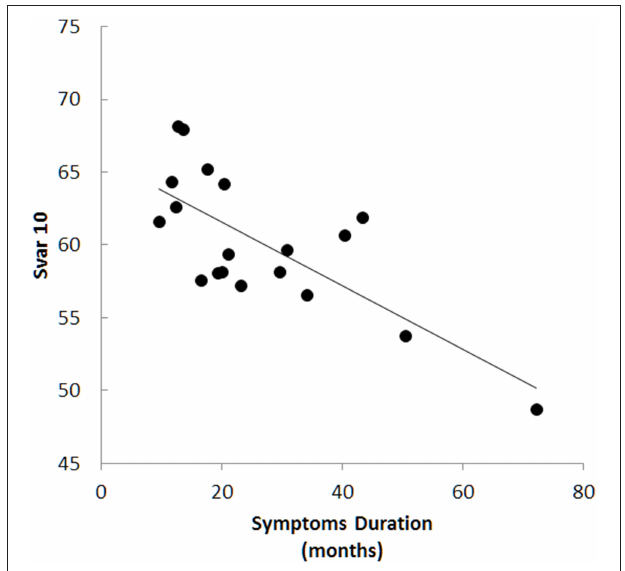
FIGURE 3 | Texture changes correlated with symptoms duration in several areas and were most prominent in the precentral gyrus, for example with sum variance in cluster 10 (Svar 10, r = − 0.73, p <